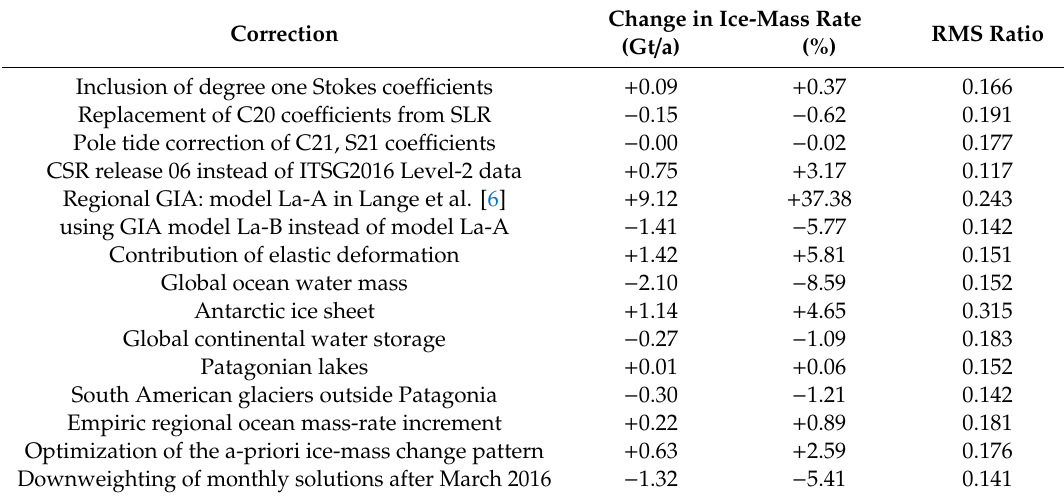
Table 2. Impact of individual corrections applied in the GRACE data analysis scheme on the derived SPI and NPI ice mass change rate. Column 2 is the di ff erence between our solution, including all of the corrections minus a modified solution, including all but the correction (or employing the alternative data set) specified in column 1. Column 3 indicates the percentage of column 2 with respect to the rate including all of the corrections ( − 24.4 Gt / a). Column 4 shows, for each modified solution, the ratio of the gravity vector RMS over the regional grid between the residuals after the adjustment and the corrected observations (for comparison, this ratio amounts to 0.152 for the solution including all